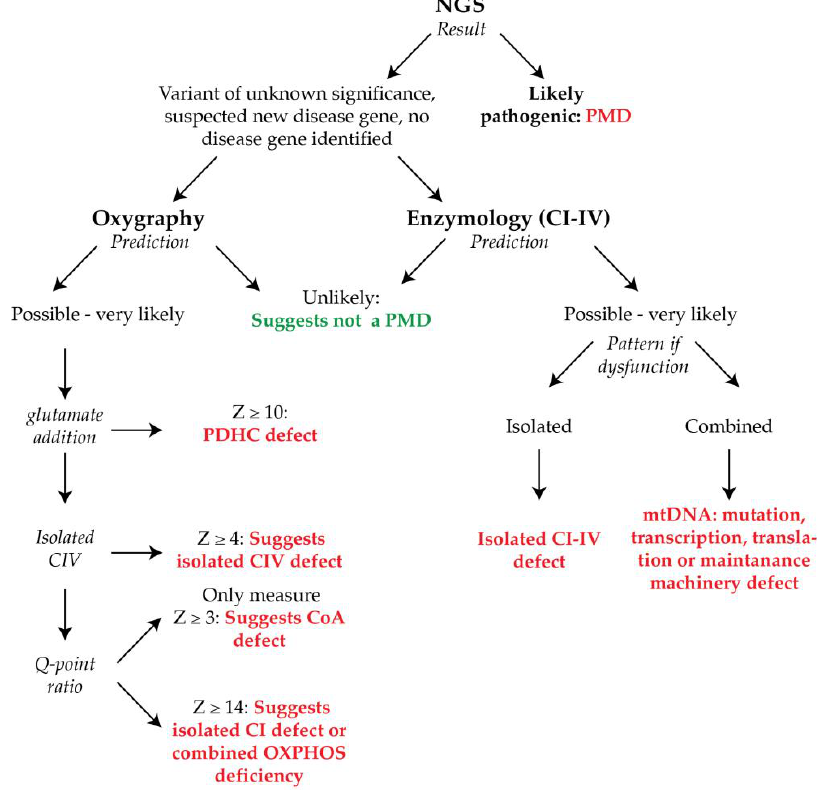
Figure 5. Diagnostic guide to interpreting enzymology and oxygraphy results in the absence of a